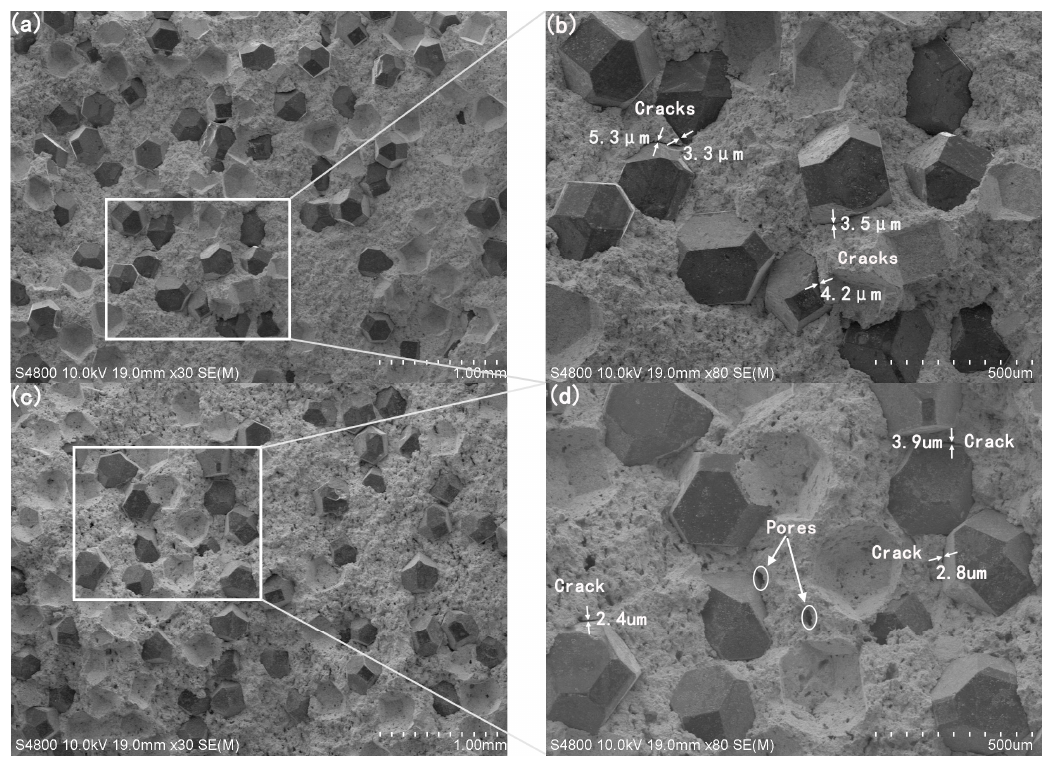
Figure 5. The fracture morphologies of samples: ( a , b ) SD0; ( c , d ) SD1. Table 3. The average width of the crack between diamond and matrix of impregnated samples.